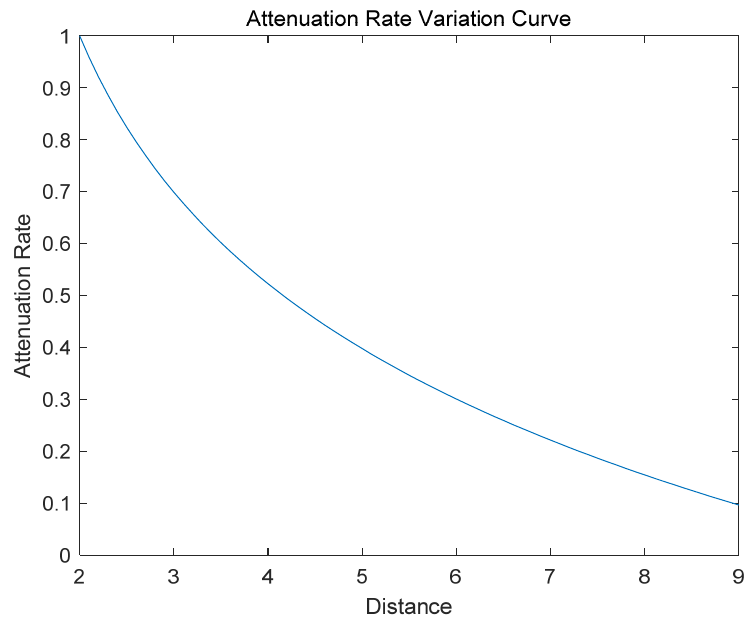
Figure 2. Variation curve.